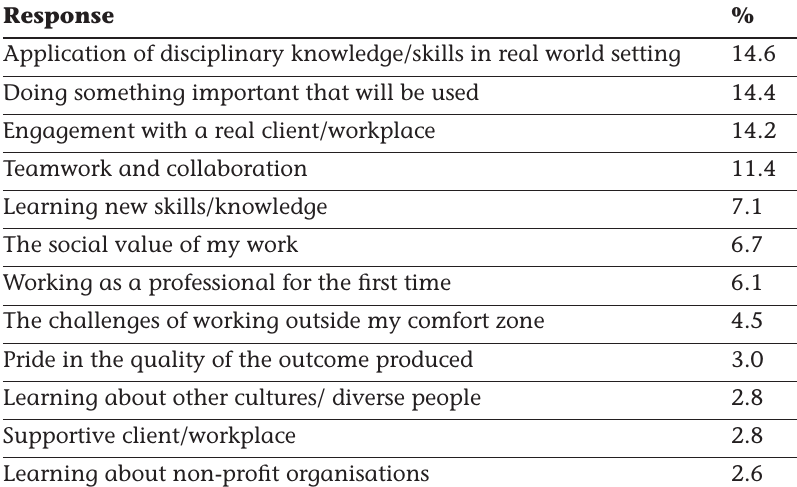
Table 3: Summary of what students liked most about their project,